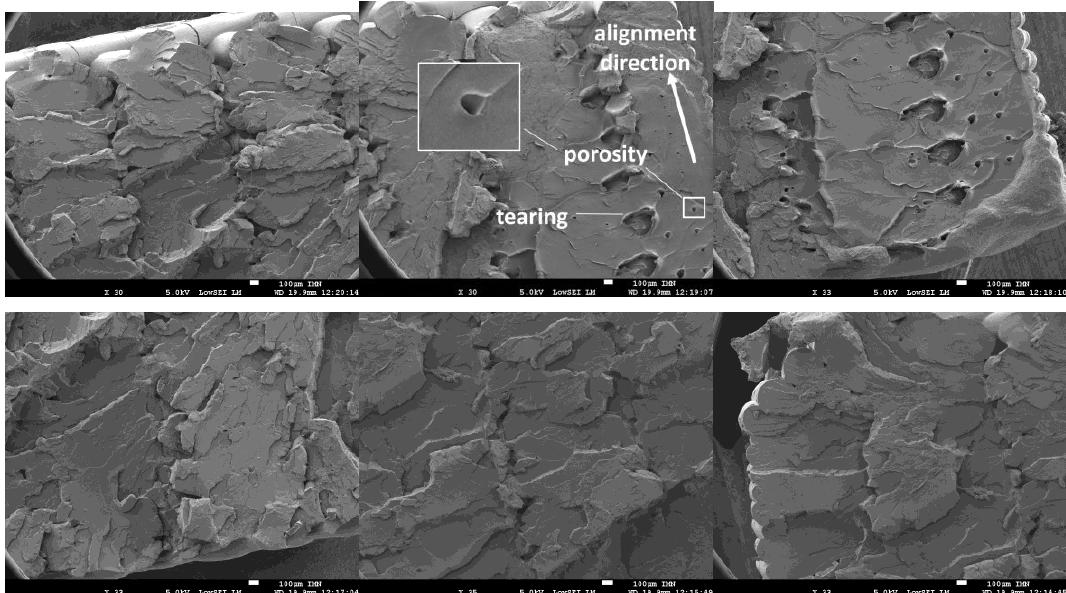
Figure 11. SEM images of fractured 3D-printed PLA ( top left : fractured filament pattern, top middle : tearing and porosity alignment, top right : zoom out view of tearing pattern, bottom left : rough fractured surface, bottom middle : zoom in view of rough fractured surface, bottom right : fracture pattern at edges).